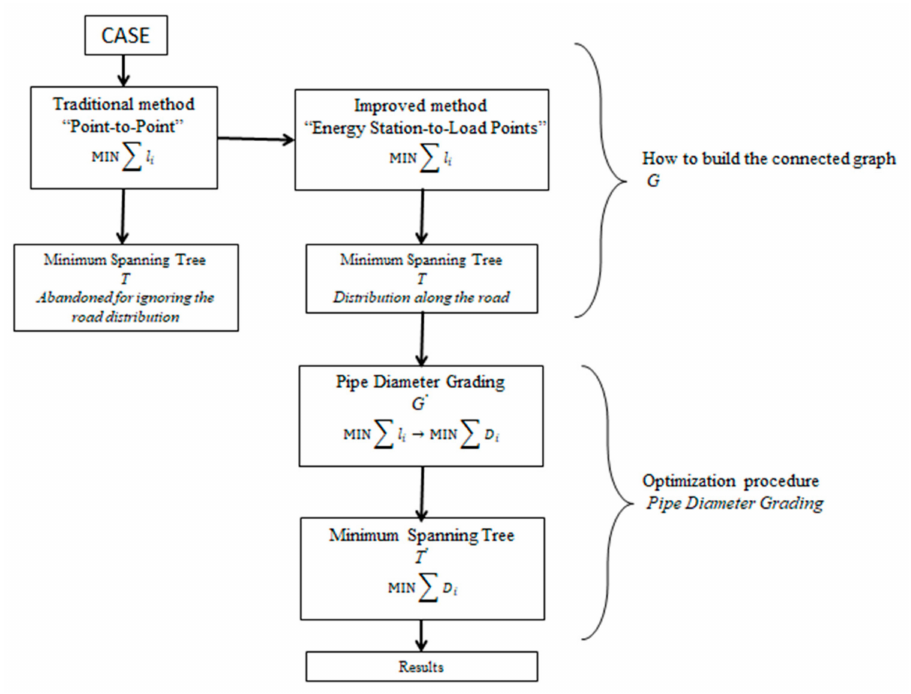
Figure 1. The main research content of this